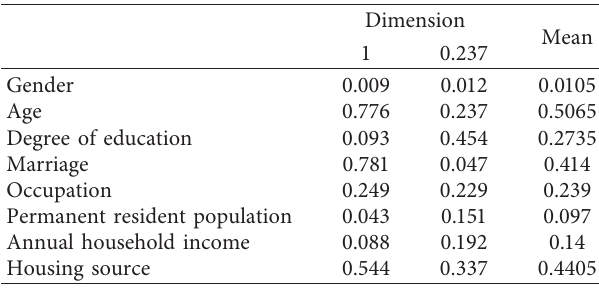
Table 3: Distinguishing measures for multivariate correspondence